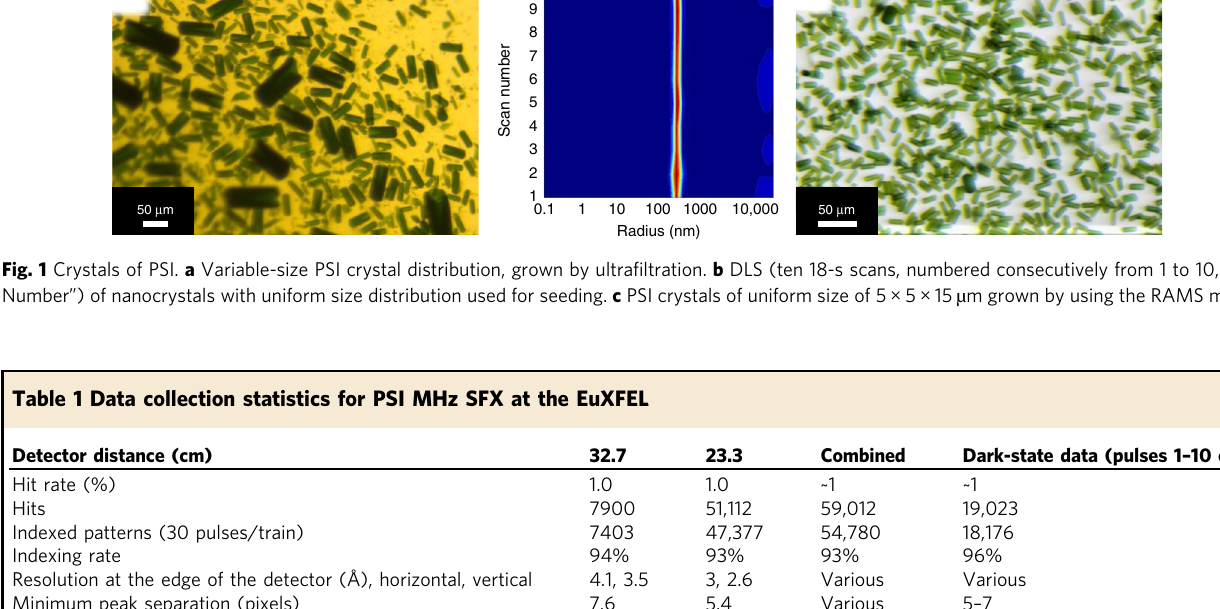
The data were used from two different detector positions. Only the fi rst ten pulses of a given train contributed to the dark PSI structure determined